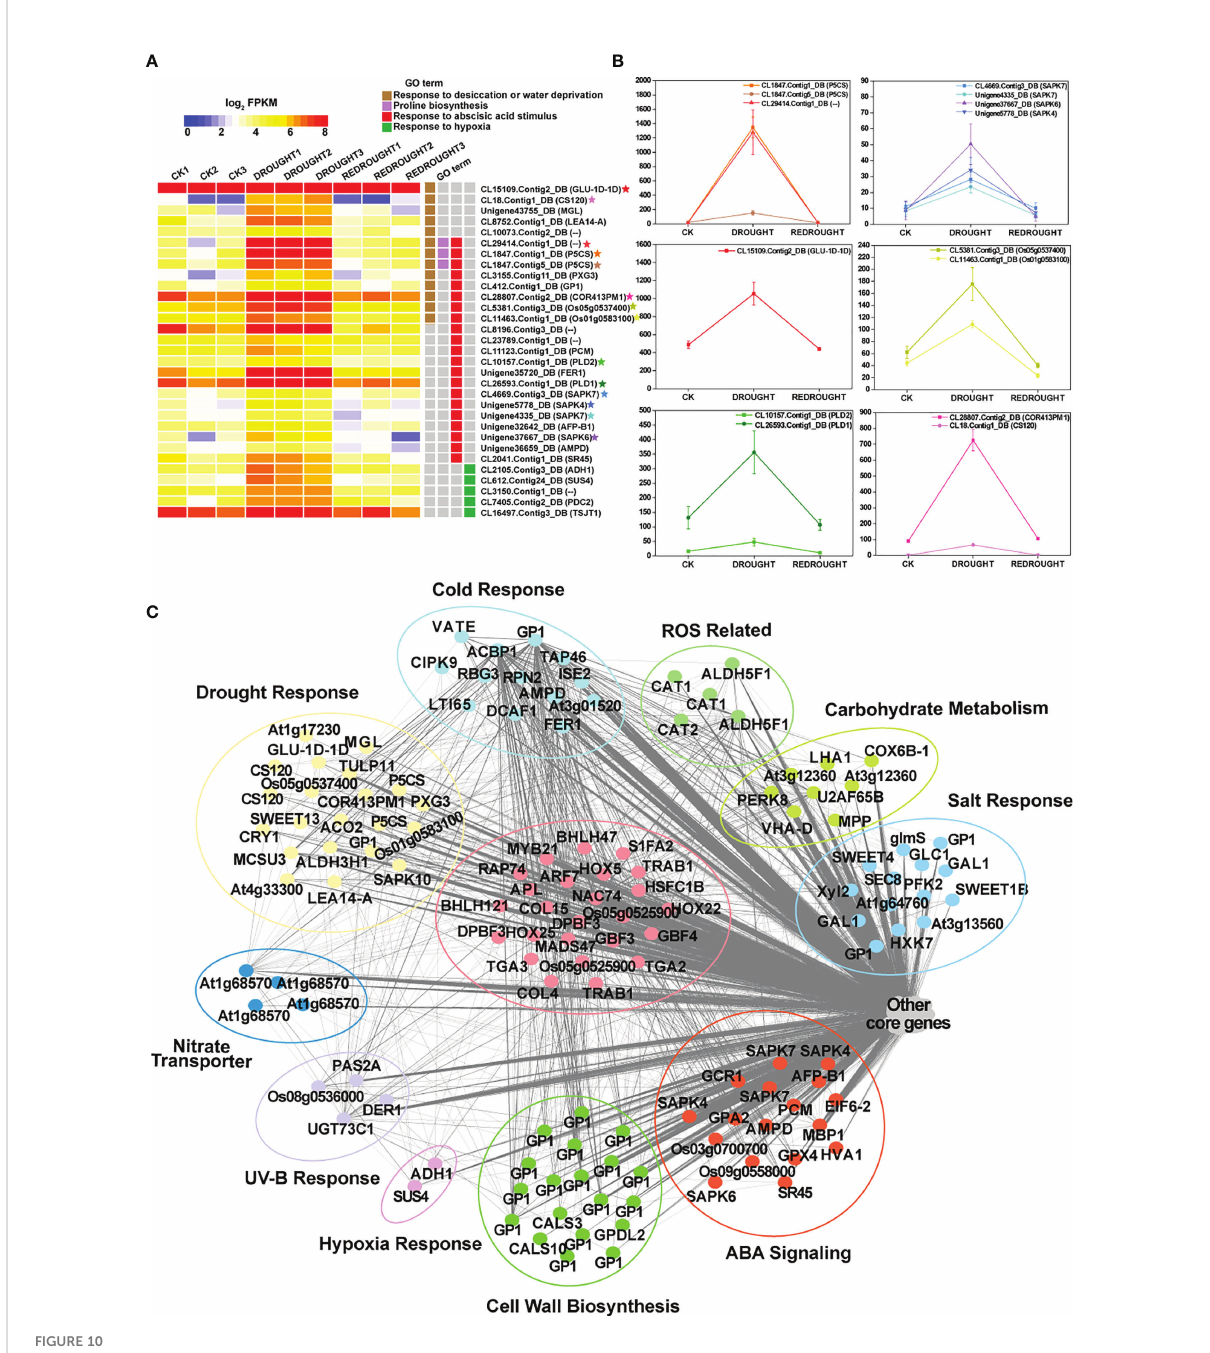
FIGURE 10 The function, expression pattern, and network of DMEblue hub genes under drought. (A) Expression pro fi les of the representative DMEblue genes (Supplementary Figure S4). Some genes marked with stars as the characterization of GO term show expression trends in line graphs. (B) The line graphs of some function genes with a star mark related to the drought stress response. The horizontal axis denotes the sampling points, and the vertical coordinates re fl ect the gene expression level (FPKM value). (C) Different functions of DMEblue hub